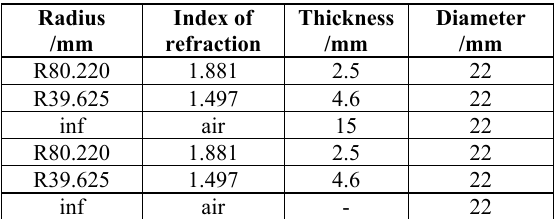
Table 1. Test system lens data.